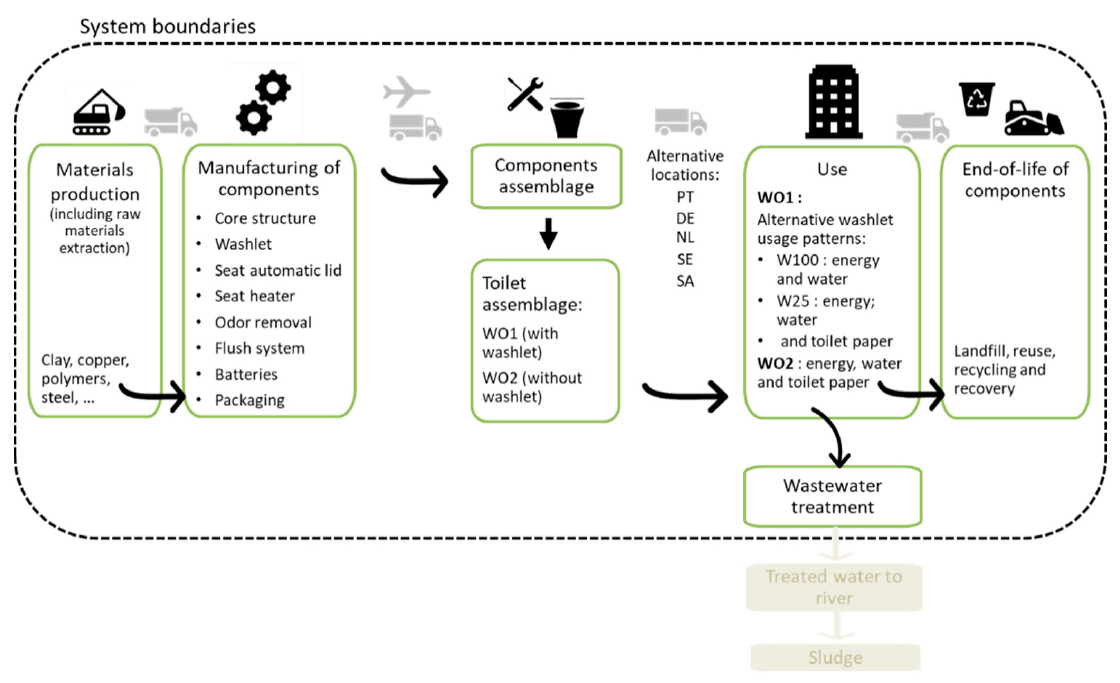
Figure 2. Life-cycle model (“cradle to grave”) of WashOne. Source: Developed by a subset of authors.